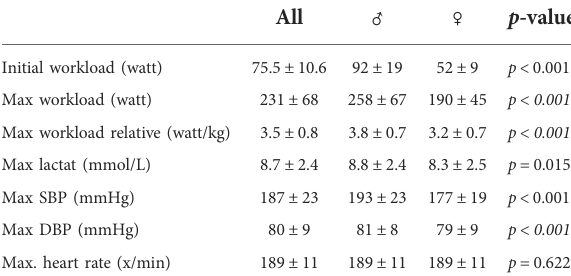
TABLE 4 Findings in exercise